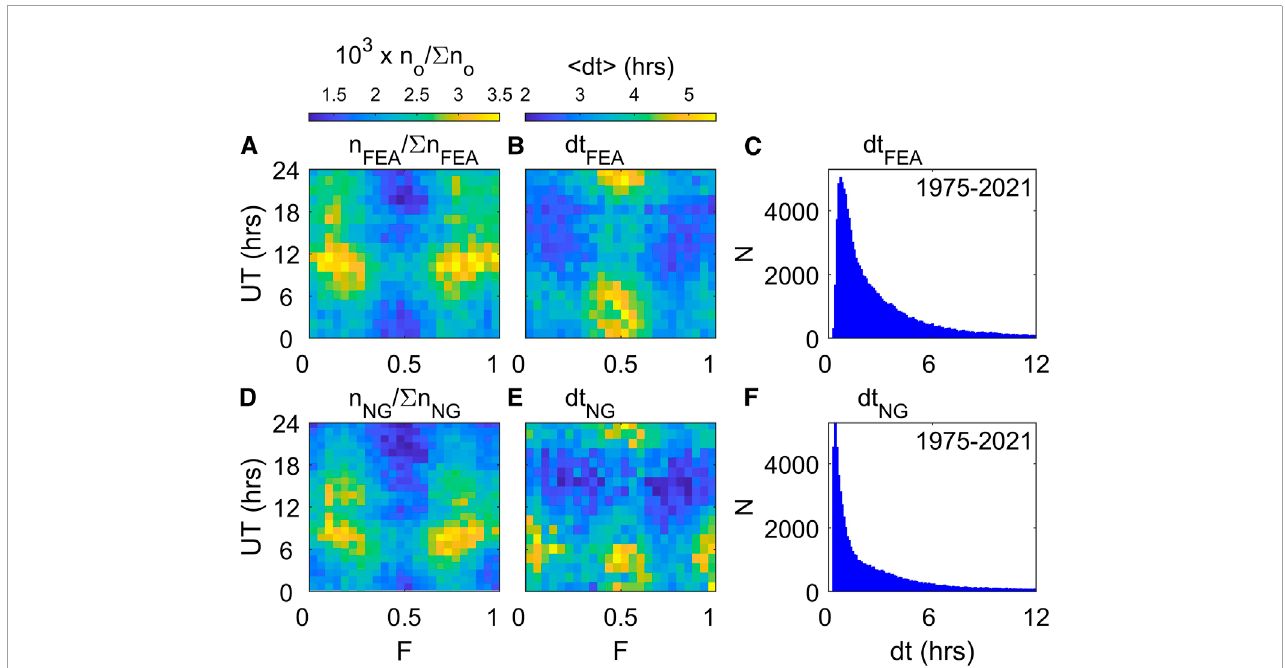
FIGURE 15 The occurrence of substorm onsets based on the SML geomagnetic index for 1976–2021, inclusive. The top row is for onsets identified by the SOPHIE algorithm of Forsyth et al. (2015) and the bottom row by the algorithm of Newell and Gjerloev, 2011a; Newell and Gjerloev, 2011b. The left-hand column are F-UT plots the numbers of onsets in bins of width 1 h in UT and 1/18 years in F , (A) being from the Forsyth et al. algorithm, n FEA and (D) being for the Newell and Gjerloev algorithm n NG . The middle column gives the corresponding F-UT plots of the mean time between onsets, dt FEA in (B) and dt NG in (E) . The right hand panels give the overall distributions of these intervals between